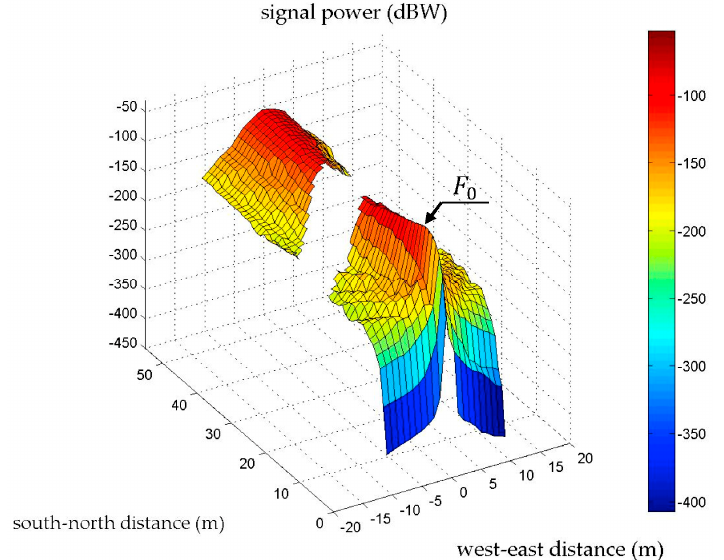
Figure 9. IF power distribution for the strong scattering area. The scattering power from the dominant facet located at (0, 7) is the strongest.